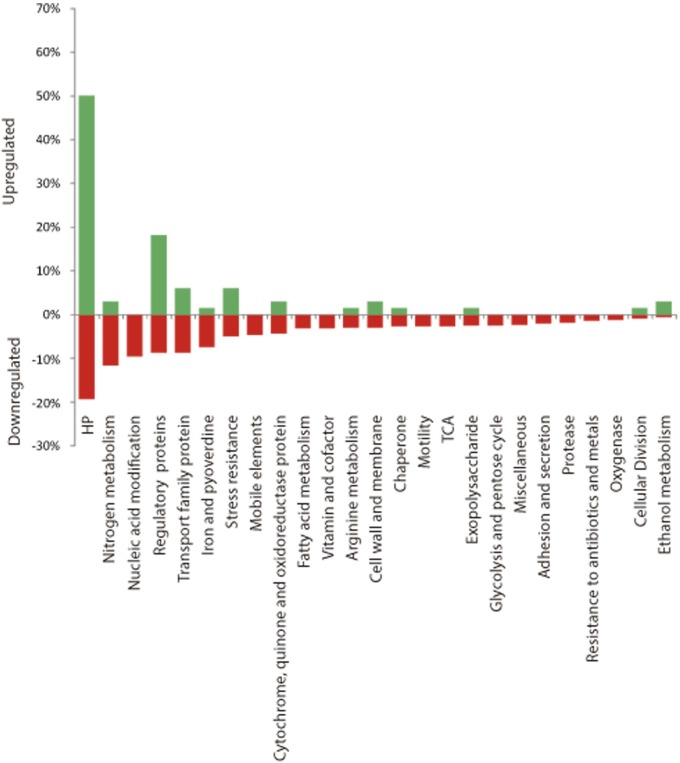
Classification of the significant differentially expressed genes under cold conditions into functional categories (Rockhopper P<0.05 and Q<0.05).Green and red bars represent up- and down-regulated genes, respectively.